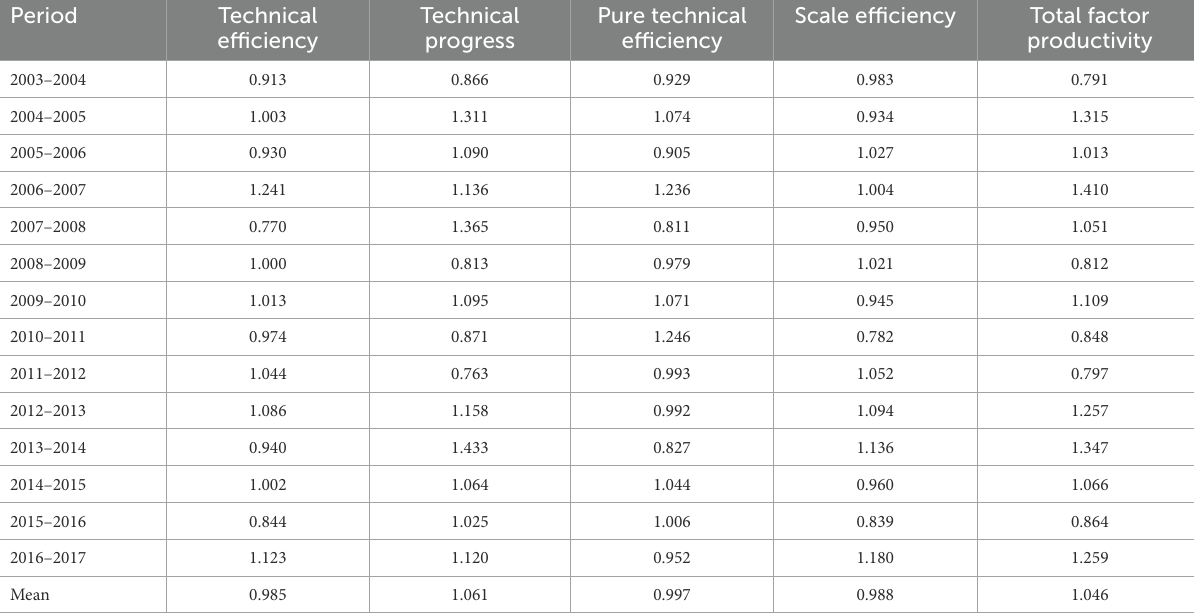
TABLE 3 The green total factor productivity of China’s service industry and its decomposition.